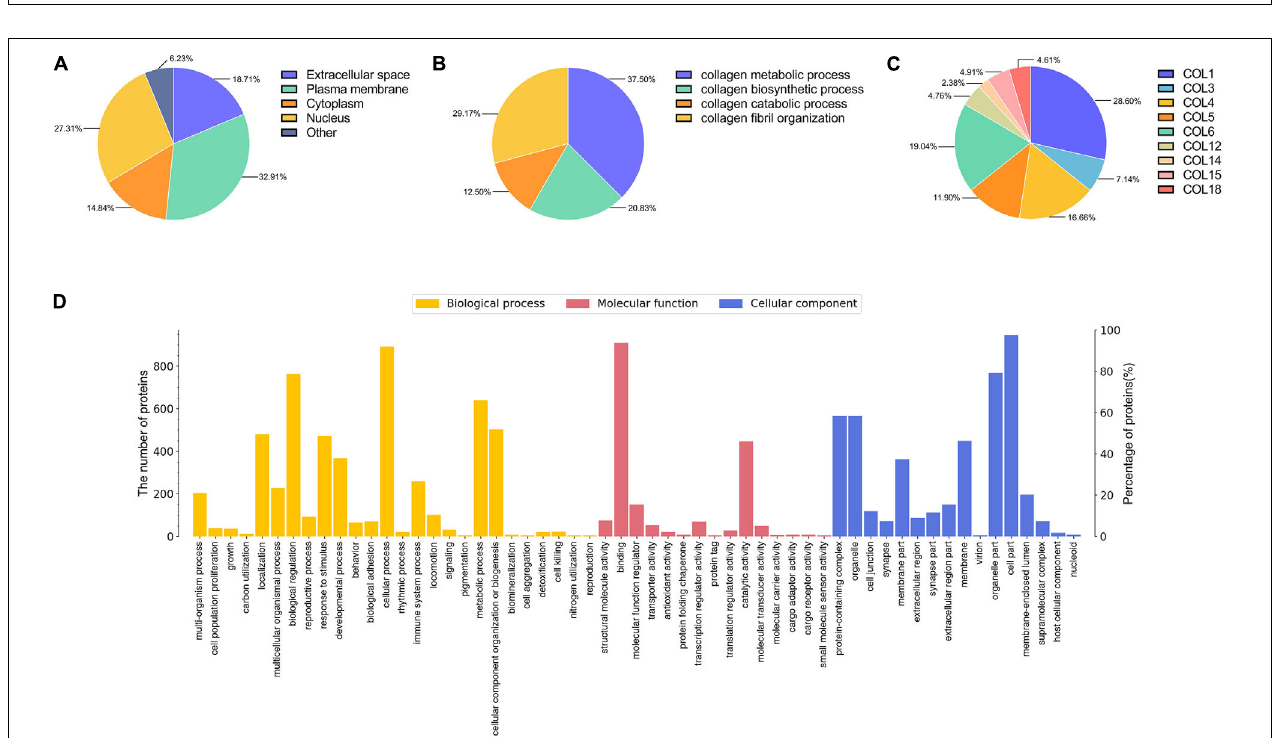
FIGURE 6 | Mass spectrometry-based quantitative proteomic analysis of ACF and classification of identified proteins. (A) Subcellular distribution of proteins in ACF. (B) Distribution of proteins involved in the biological process of collagen in ACF. (C) Distribution of collagen types in ACF. The most abundant collagen types were type I, type VI, and type IV. (D) Biological processes and molecular function and cellular components categories of identified proteins in ACF.